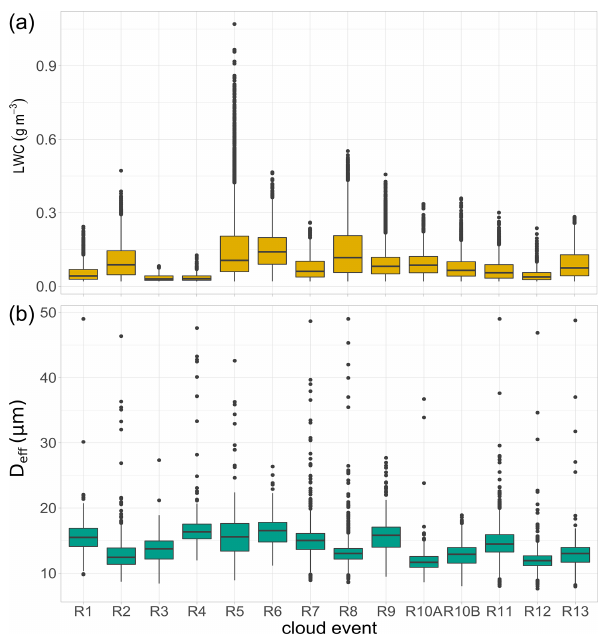
Figure 2. Distribution of liquid water content (LWC) and effective diameter ( D eff ) of cloud droplets observed during each cloud event in Réunion. R1 to R13 refer to individual cloud samples. Lower and upper box boundaries represent the 25th and 75th percentiles, respectively; line inside box shows the median, and lower and upper error lines depict the 10th and 90th percentiles, respectively; filled black circles represent the data falling outside the 10th and 90th